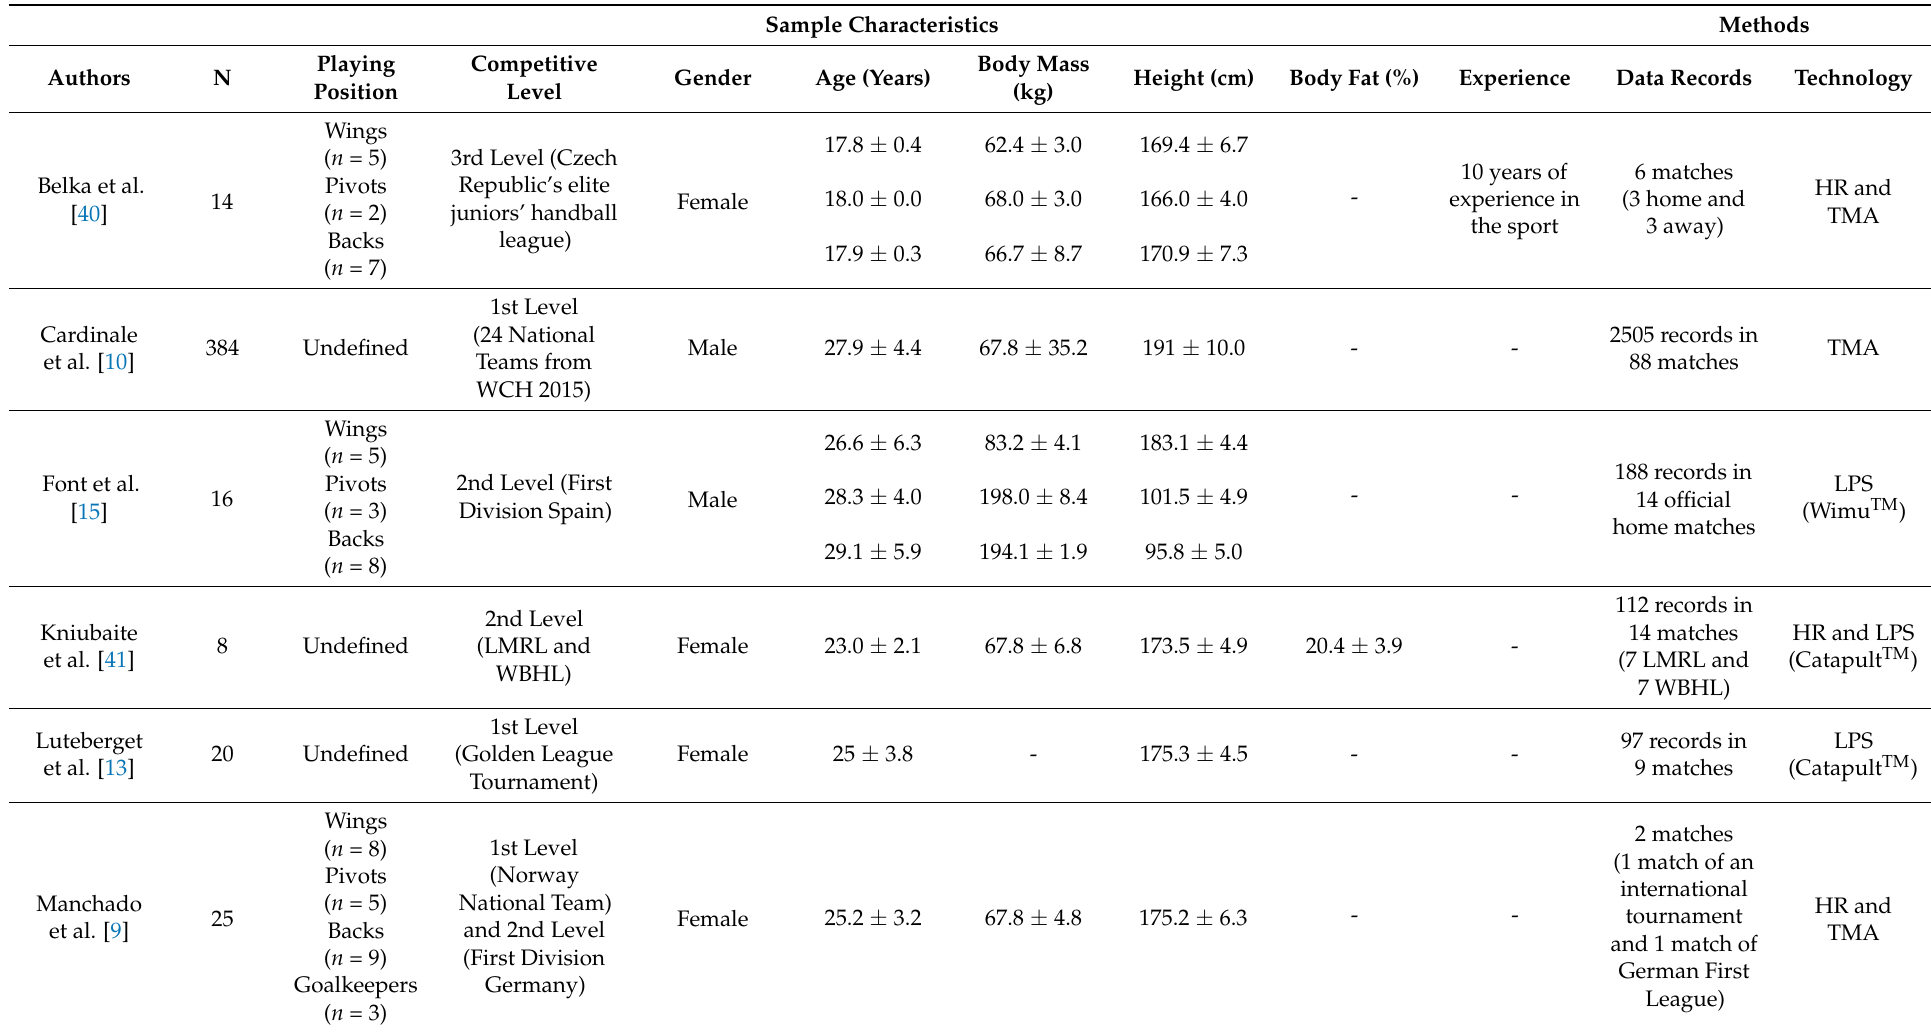
Table 1. Summary of the sample characteristics and